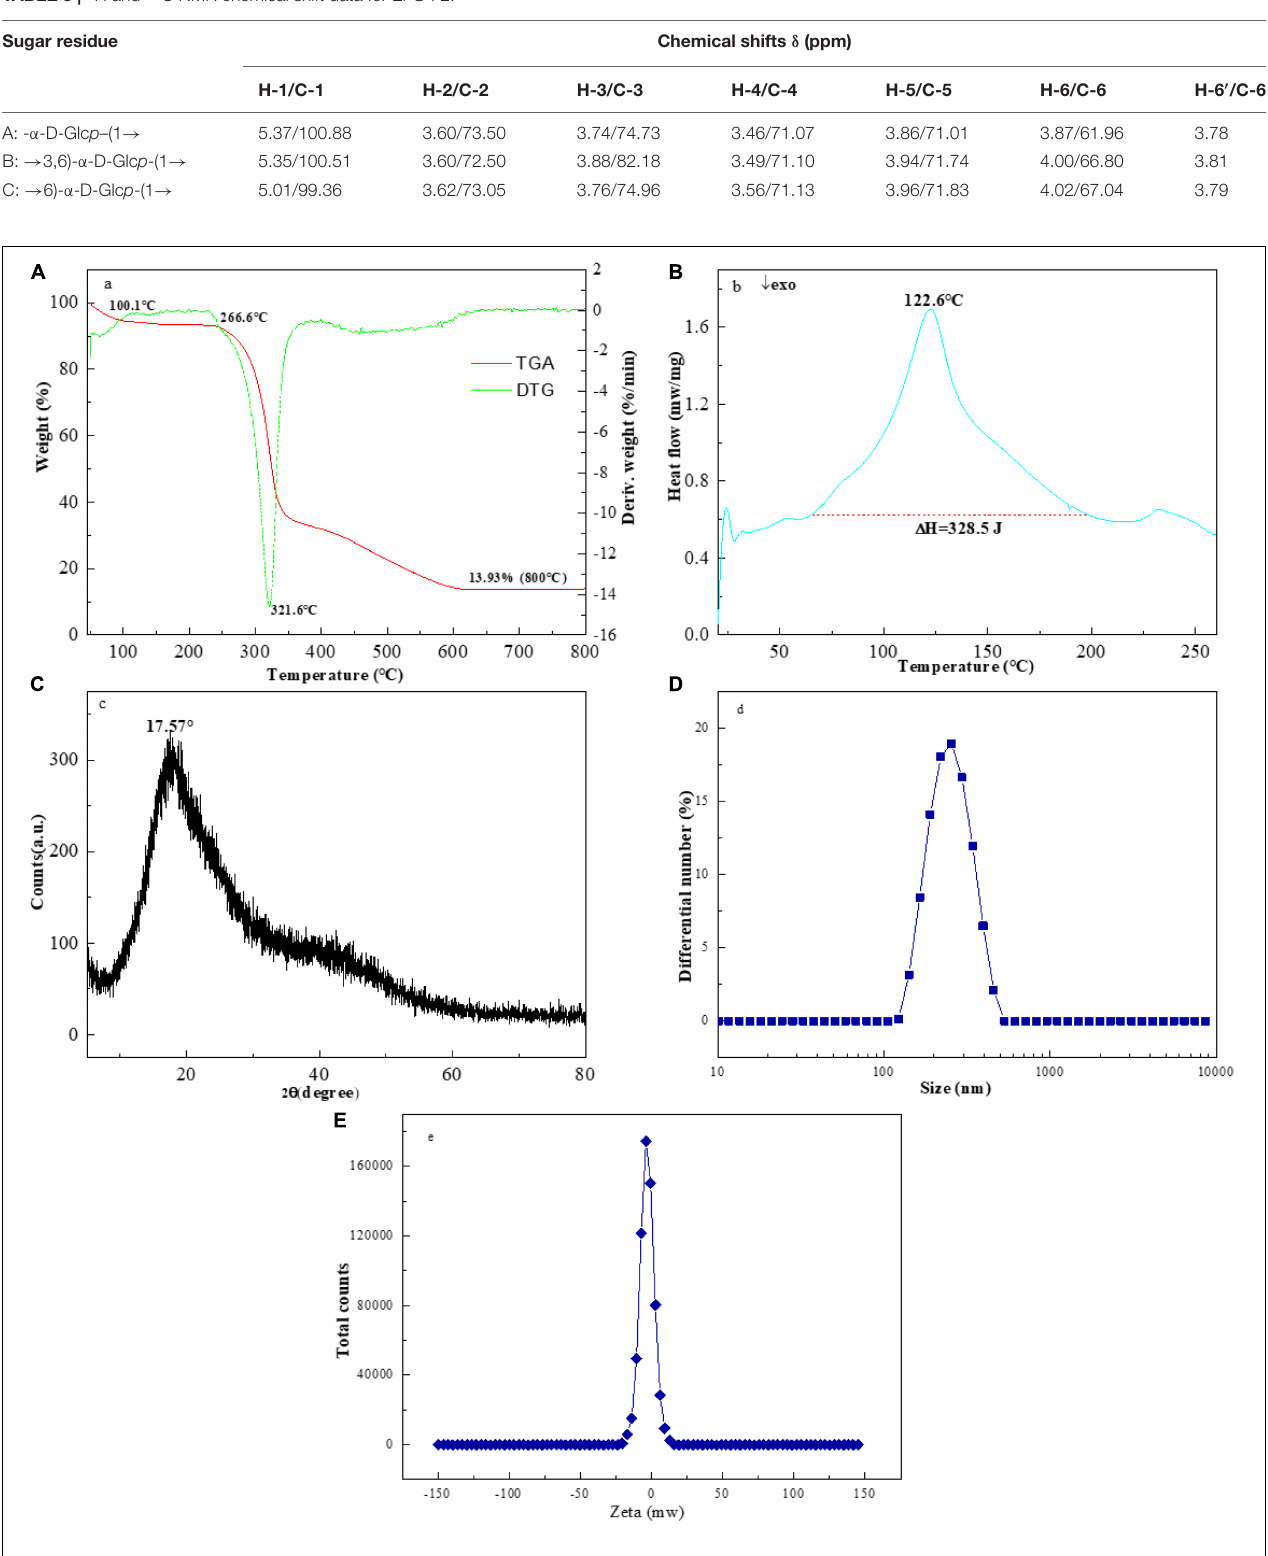
Frontiers in Microbiology |